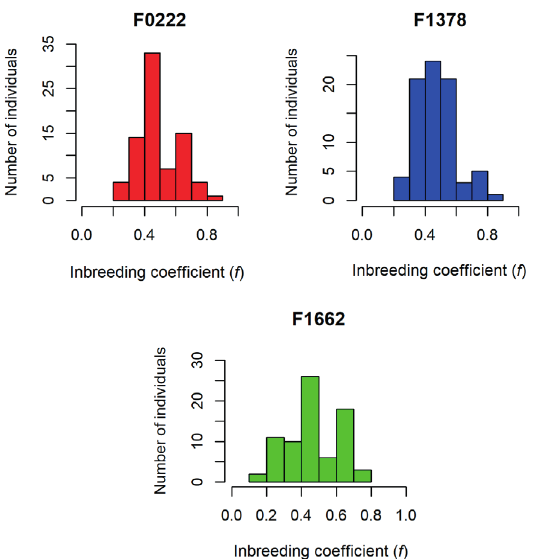
Figure 2 - Distribution of the inbreeding coefficient ( f ) of the S cassava individuals from the self-pollination of the accession BGM0222 (F0222), BGM1378 (F1378) and BGM1662 (F1662).